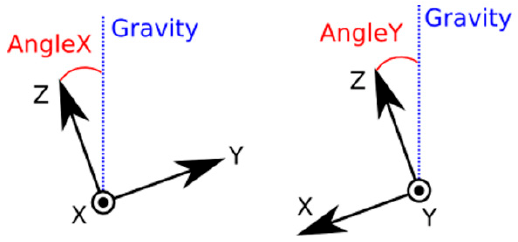
Figure 12. NAO Inertial Unit.